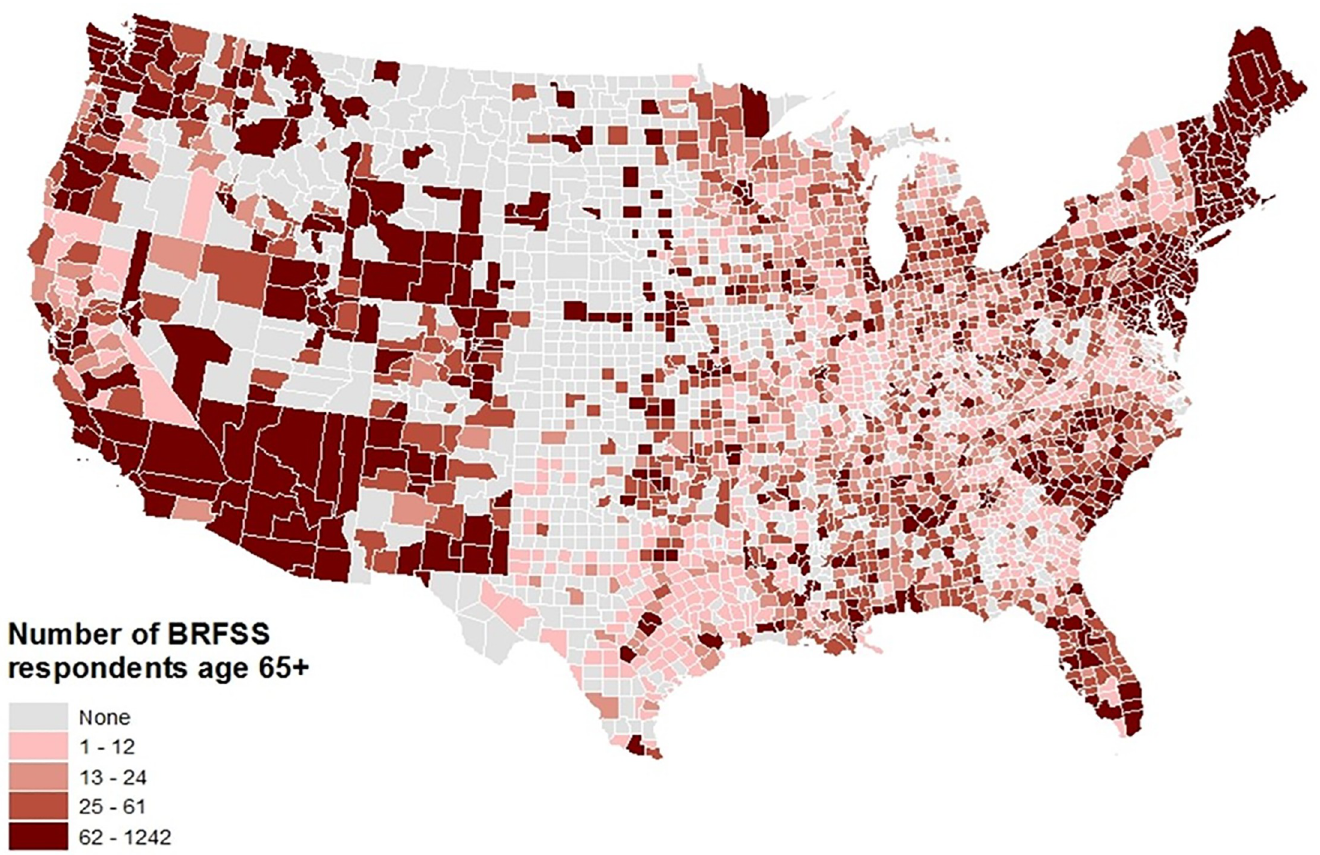
Fig 2. Geographic distribution of the analytic sample: Number of respondents aged 65 and above from the 2012 Behavioral Risk Factor Surveillance System.